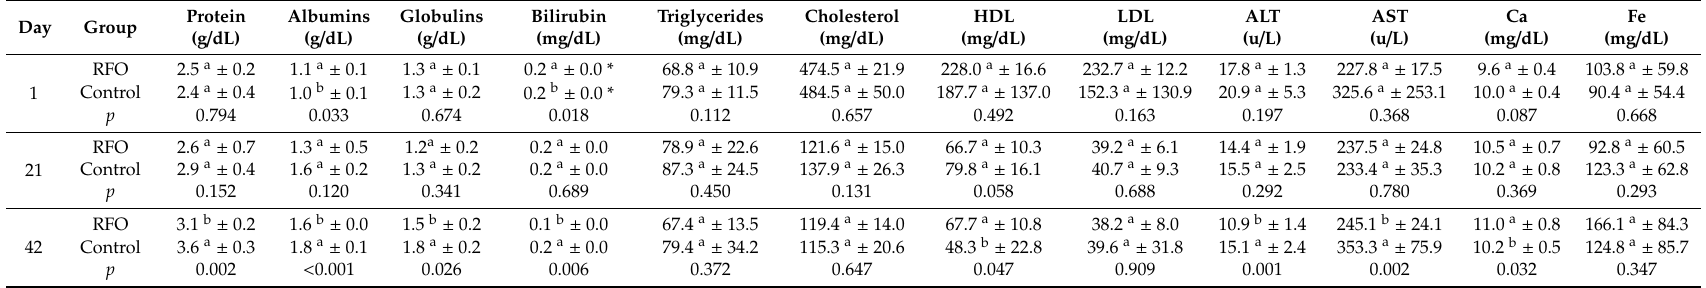
* The exact mean ± SD for the RFO was 0.163 ± 0.005 and for the Control was 0.18 ± 0.014; RFO—ra ffi nose family oligosaccharides, HDL—cholesterol high density lipoprotein, LDL—cholesterol low density lipoprotein, ALT—alanine aminotransferase, AST—aspartate aminotransferase, Ca—calcium, Fe—ferrum; a,b mean values with the same letter are not significantly di ff erent at p ≤